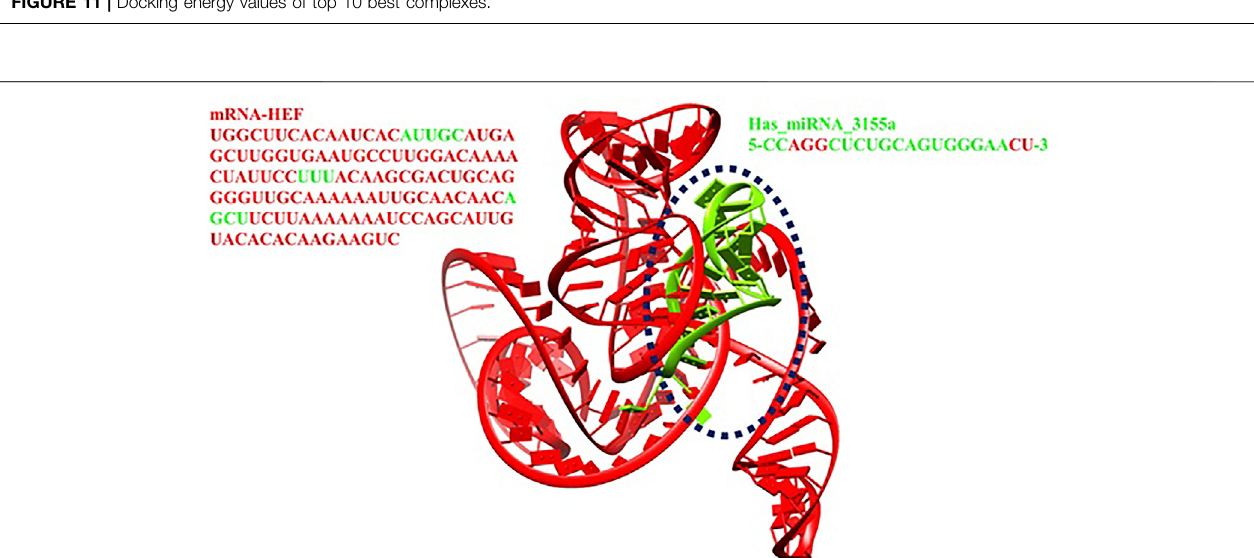
FIGURE 11 | Docking energy values of top 10 best complexes.